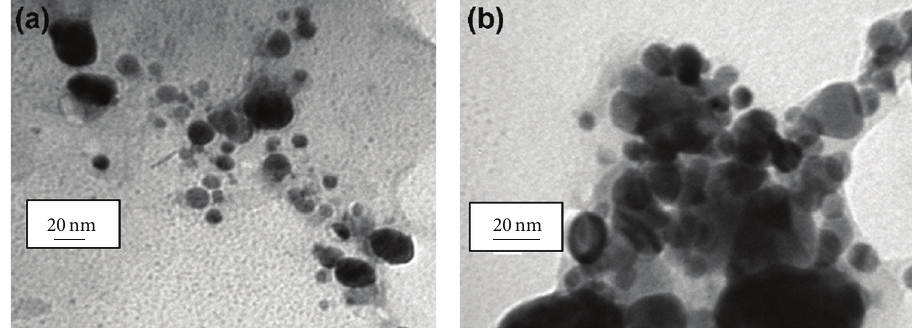
Figure 6: TEM micrographs with (a) 1mL and (b) 5 mL olive leaf extract [48] (reproduced with permission from the journal).